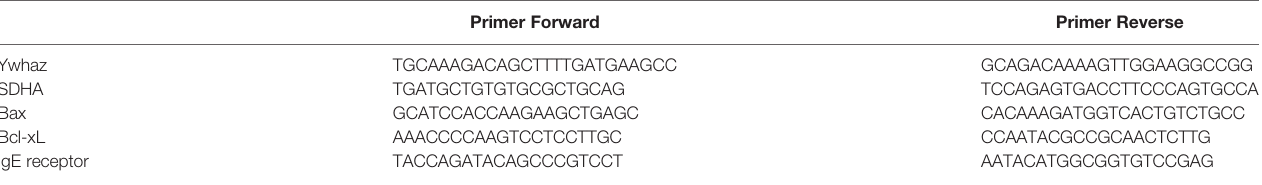
TABLE 1 | Primer sequences for quantifying Ywhaz, SDHA, Bax, Bcl-xL and IgE receptor gene expression